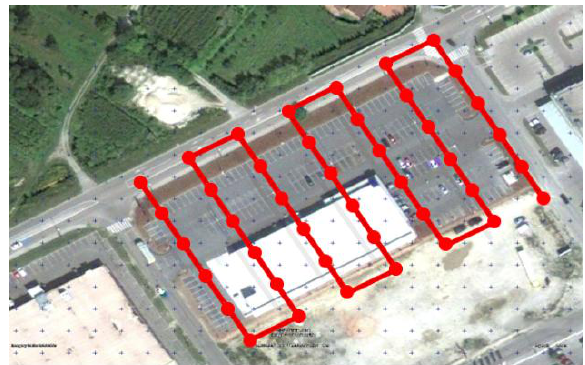
Figure 2. UAV’s flight path